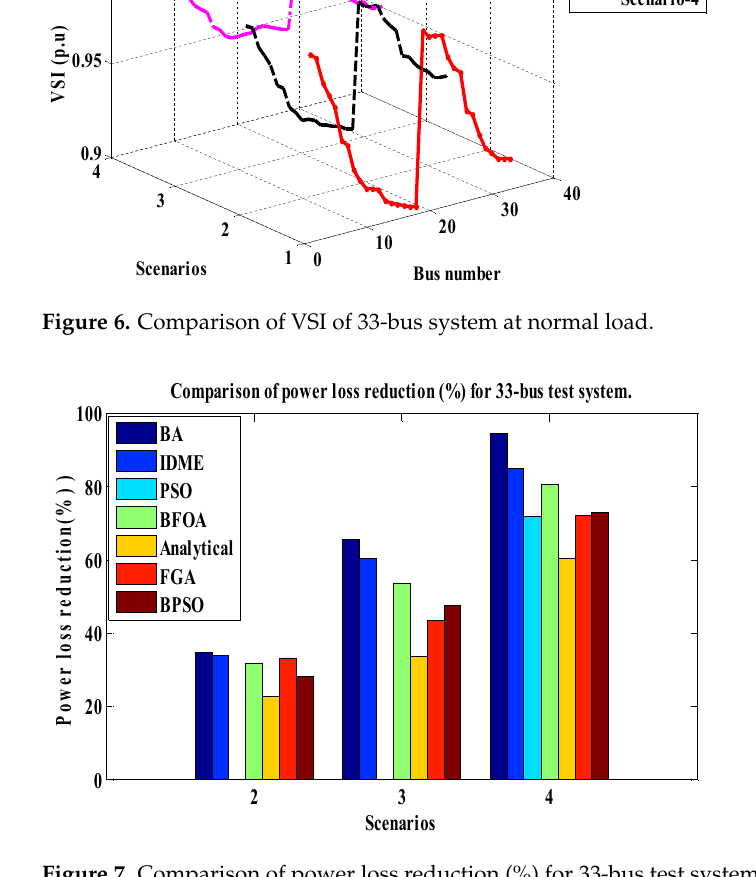
Figure 7. Comparison of power loss reduction (%) for 33-bus test system. Table 3. Results of IEEE 33 RDS (various load models).